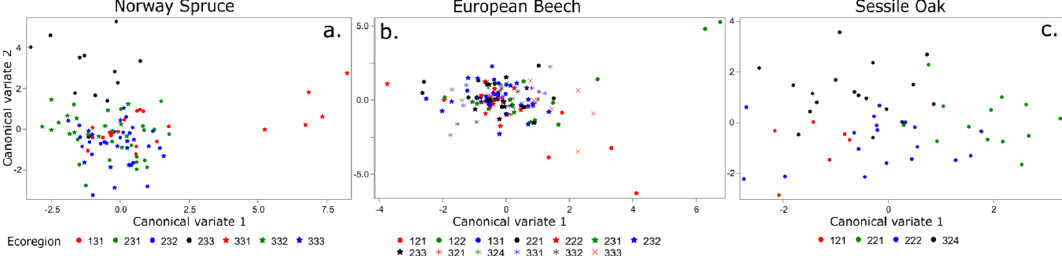
Figure 7. Grouping by ecoregions for Norway spruce ( a ), European beech ( b ), and Sessile oak ( c ) with canonical variables as axes. Because the same conclusion is reached for DBHi and BAi only the plots for DBHi are presented.